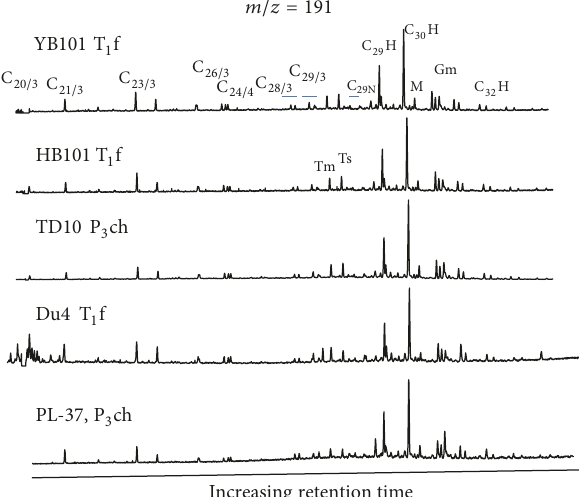
Figure 4: Partial GC-MS chromatograms ( 𝑚/𝑧 = 191 ) for extra- ctable organic matter from solid bitumen samples.